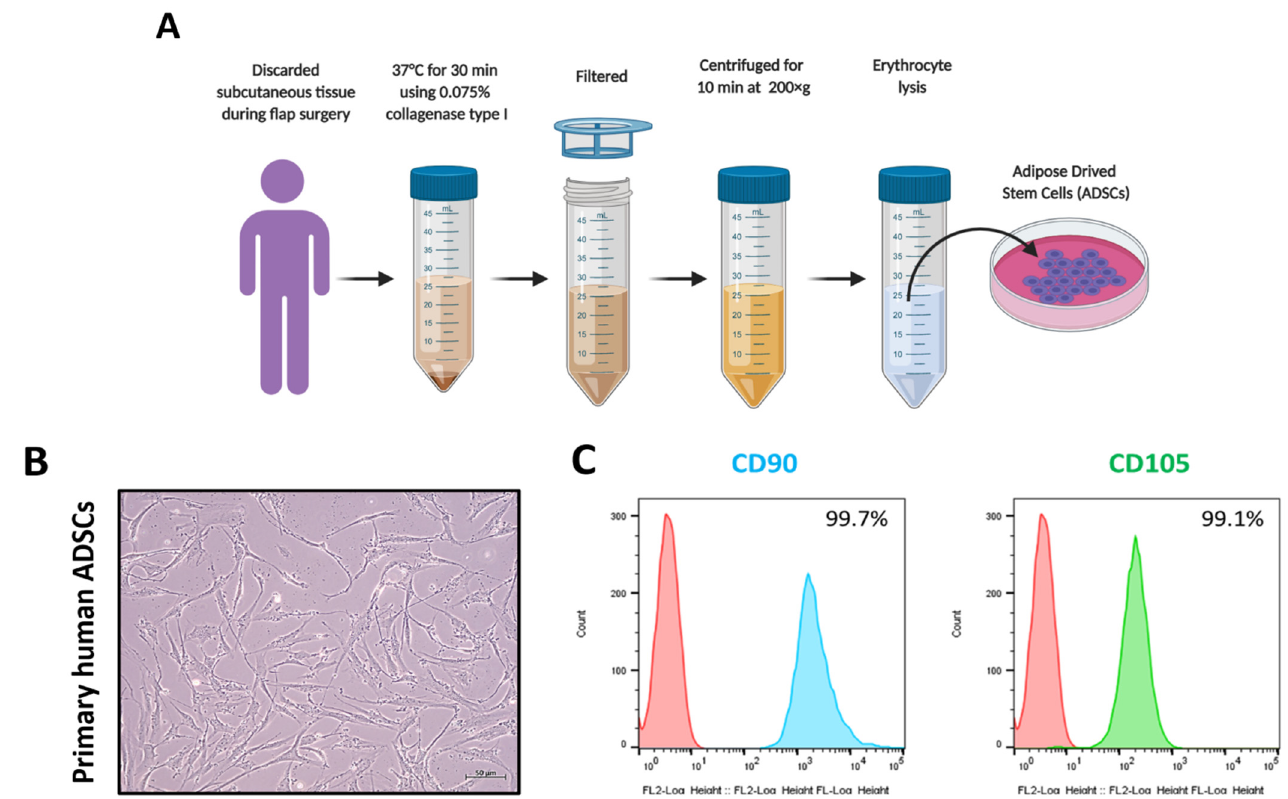
Figure 1. Isolation and Characterization of human primary ADSCs. ( A ) Schematic diagram, as created with BioRender.com software, of the process used for isolating the human primary ADSCs. ( B ) Phase-contrast imaging of the human primary ADSCs (scale bar: 50 µm). ( C ) Flow cytometry analysis of CD90 and CD105 in human primary ADSCs.